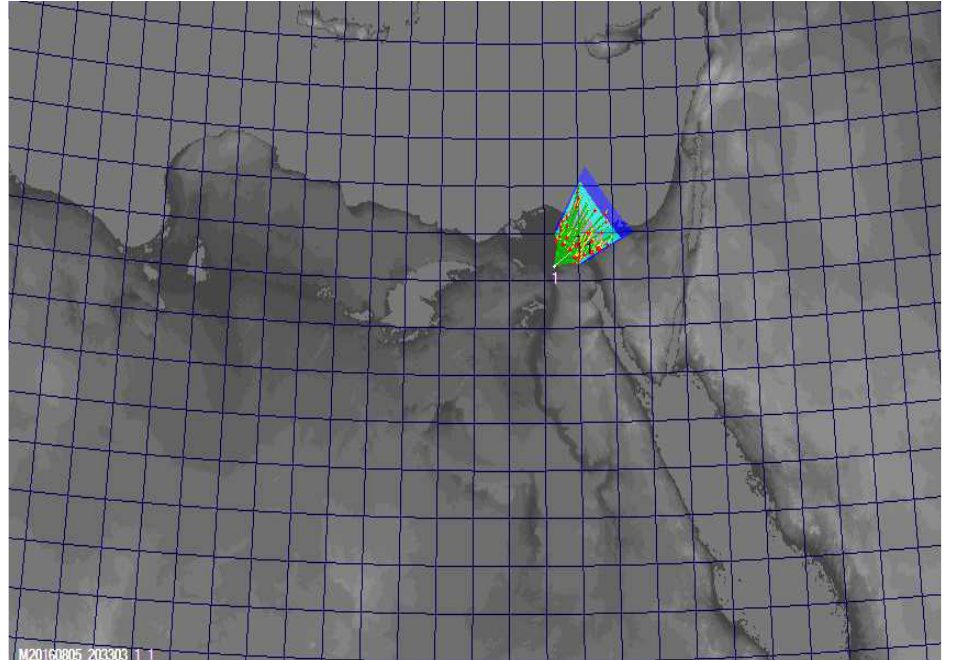
Fig. 5 Ground map for meteors observation during 5-13 August